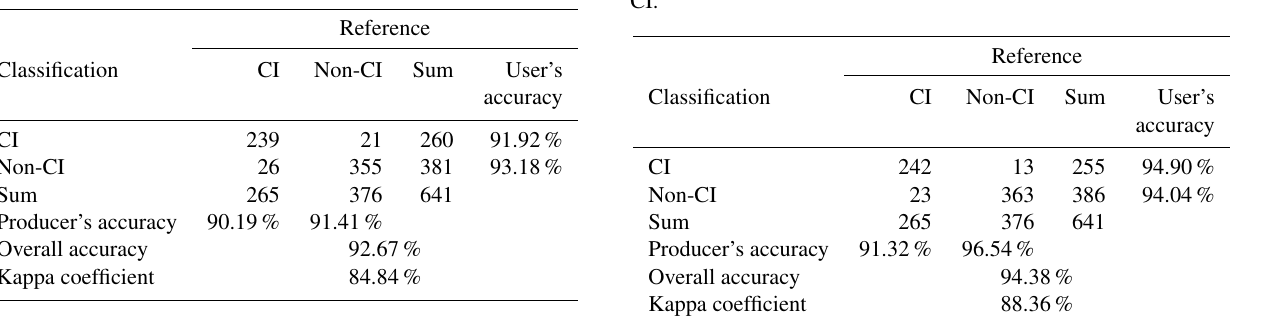
Table 4. Assessment of the DT model for CI detection using the test data.